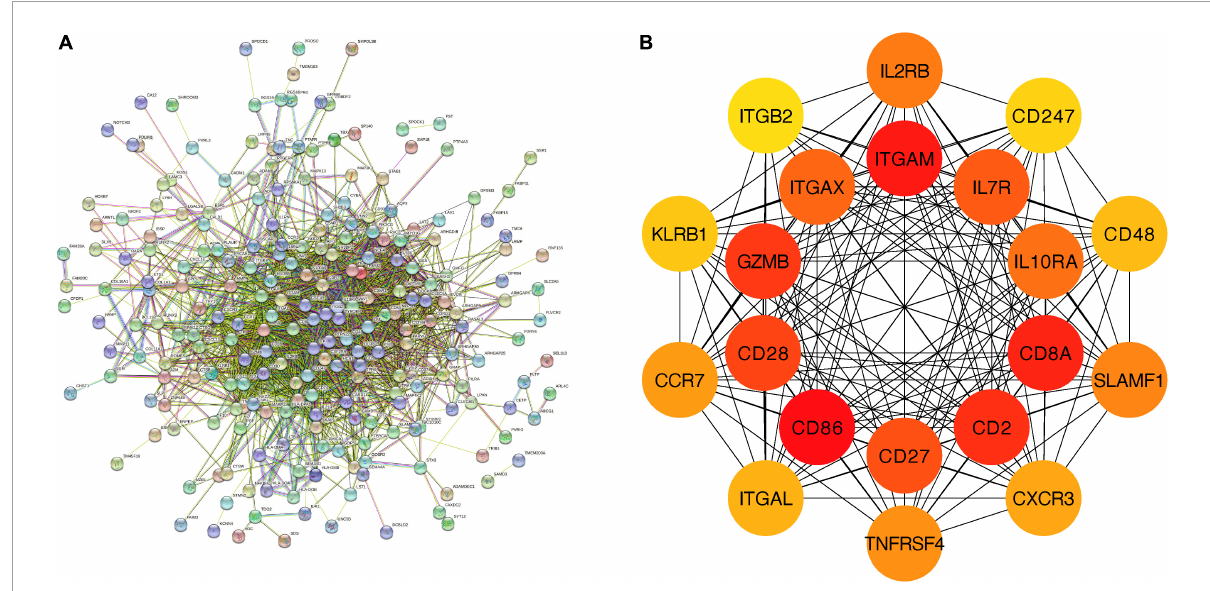
FIGURE6 PPI network and hub genes of feature genes. (A) The interaction between 279 feature genes. Minimum required interaction score = 0.4, 275 nodes and 1,705 edges were included in the PPI network. (B) Top 20 hub